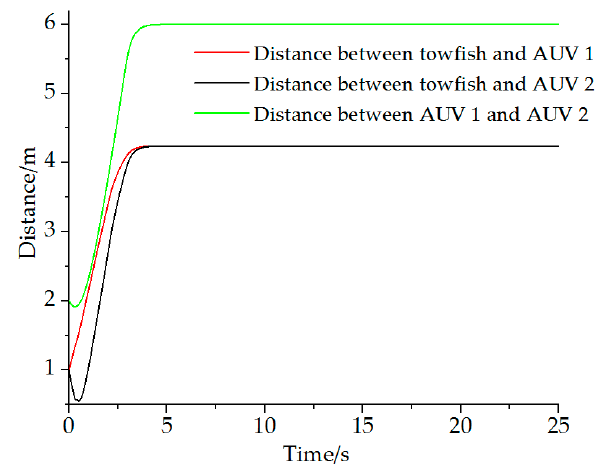
Figure 10. Distance between vehicles.